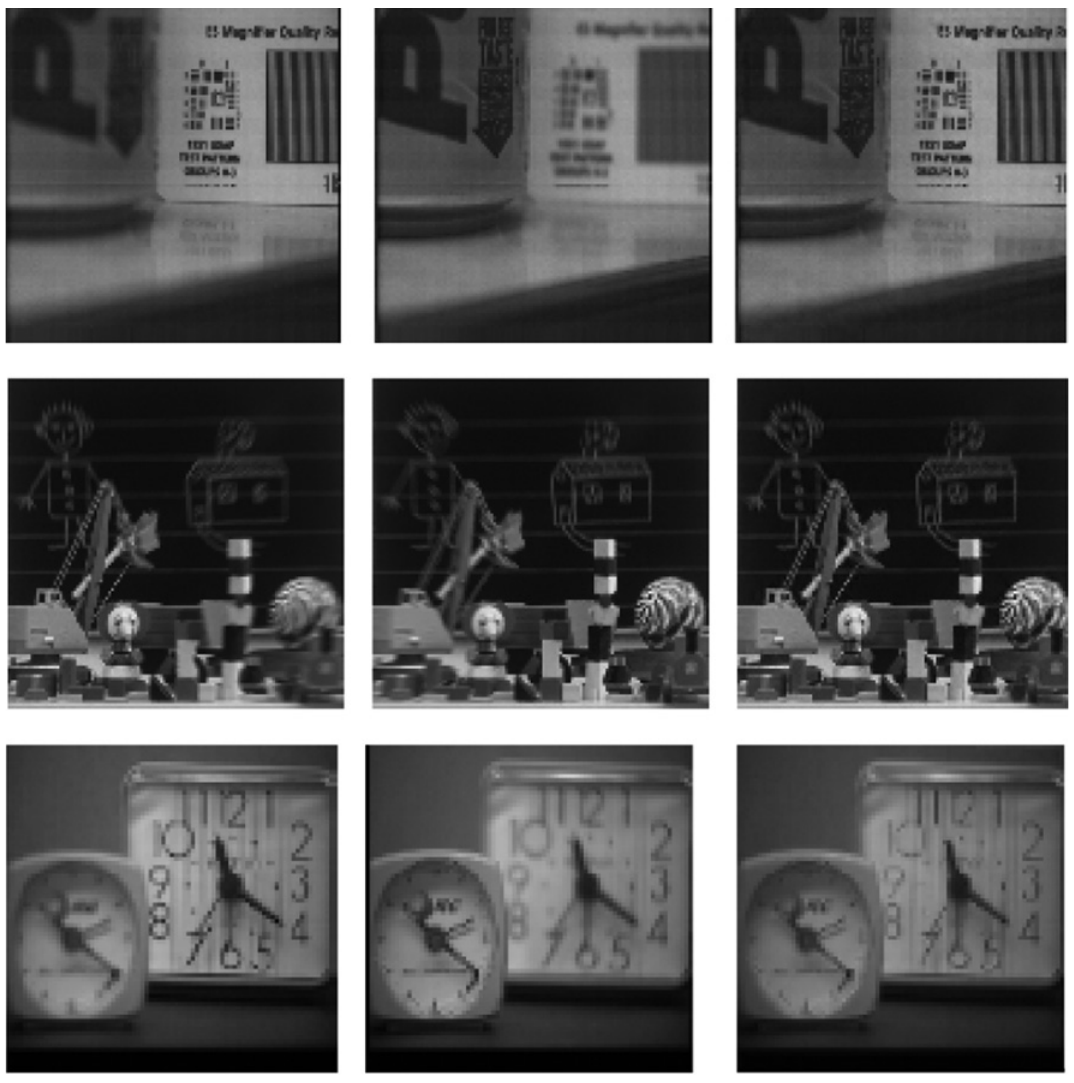
Figure 7: Fusion Results Based on Contourlet Transform